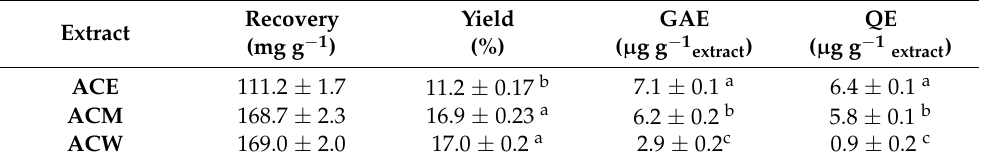
Table 1. Recovery, yield, TPC and TFC of the extracts from A. cherimola leaves. Extract